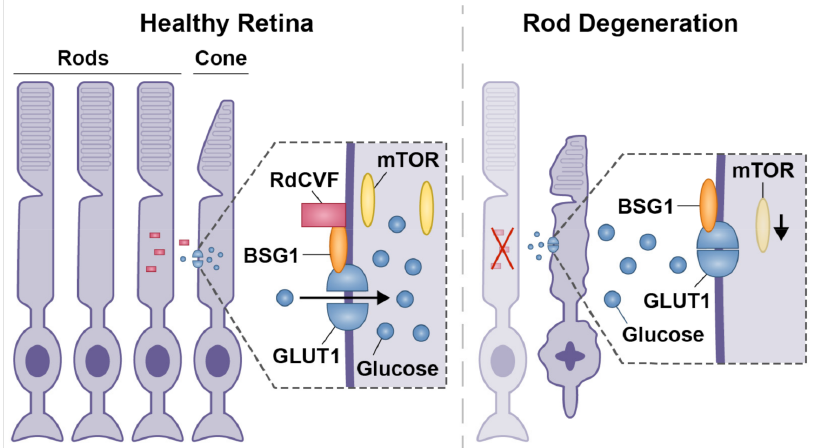
Figure 2. Theorised mechanism of secondary cone degeneration. In healthy retina, rods produce RdCVF to support cone function by binding to BSG1, allowing glucose to enter the cones via the GLUT1 receptor. When rods are degenerated as a result of disease, RdCVF is no longer produced and the cone GLUT1 receptor remains inactive. Dysregulation of glucose uptake into cones causes a decrease in mTOR, and cones begin to degenerate secondary to the loss of